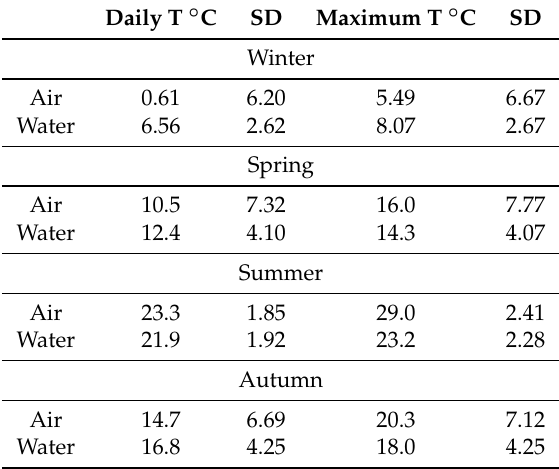
Table 7. Mean and variance of the mean daily air temperature and mean daily maximum air temperature over the period of data